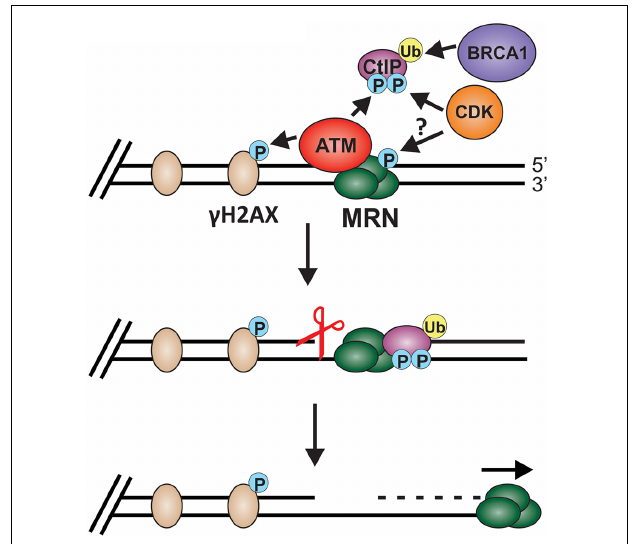
FIGURE 6 | Model of short-range resection. Short-range resection by MRN is stimulated by CtIP. Localization of CtIP to the chromatin is dependent on phosphorylation of CtIP by CDK and ATM and ubiquitination by BRCA1. CDK has also been proposed to phosphorylate MRX in budding yeast in a cell cycle-dependent manner, suggesting that CDK may regulate MRN in mammals. Phosphorylation of H2AX by ATM also promotes short-range resection and the recruitment of DSB machinery. Upon localization with MRN, CtIP stimulates both MRN endonuclease (indicated by the scissors) and 3 (cid:48) -to-5 (cid:48) exonuclease activity to facilitate short-range resection. (P: phosphorylation; Ub: